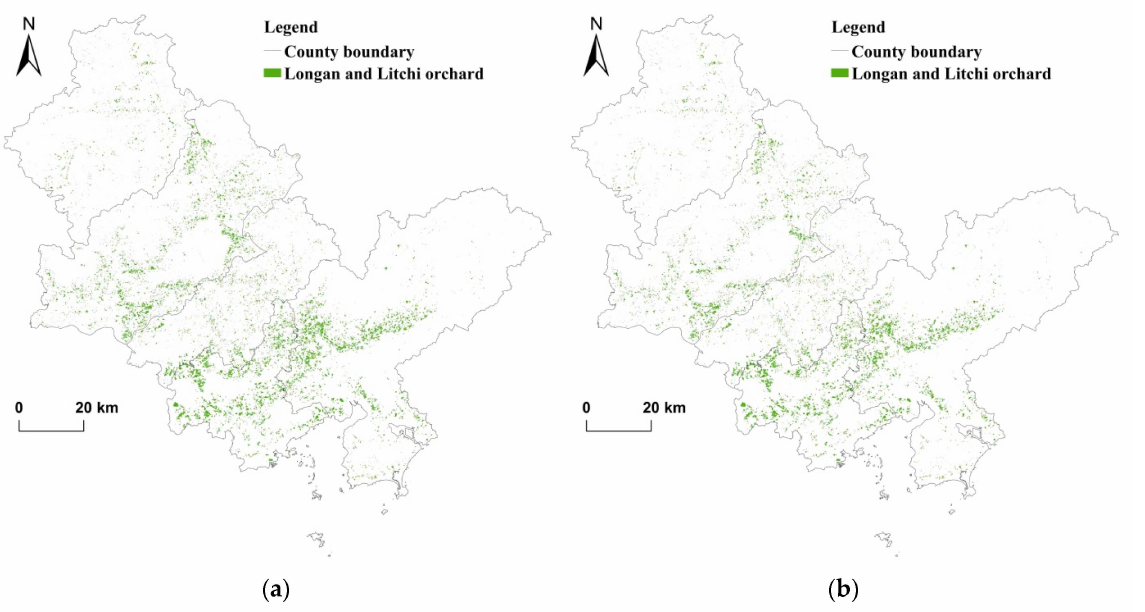
Figure 2. Spatial distribution of longan and litchi orchards in the study region in 2015–2019. ( a ) 2015; ( b )